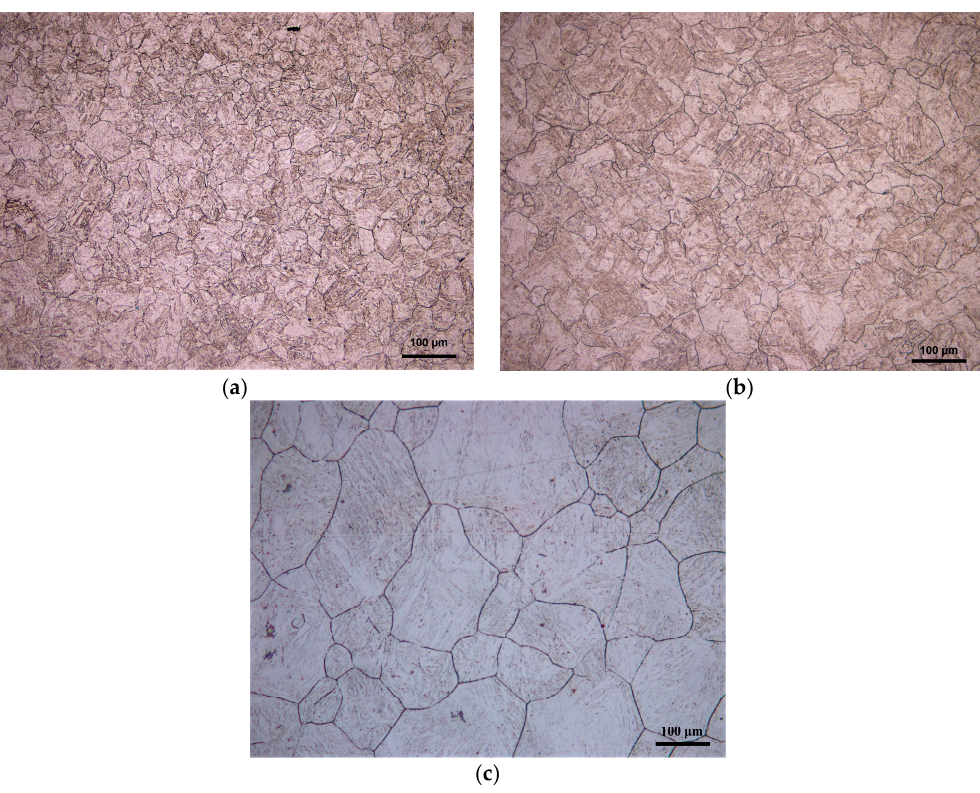
Figure 4. Microstructure of 20Mn5 steel compressed to a true strain of 0.7 under temperature of 1200 °C and strain rates of: ( a ) 1/s; ( b ) 0.1/s; ( c ) 0.01/s.